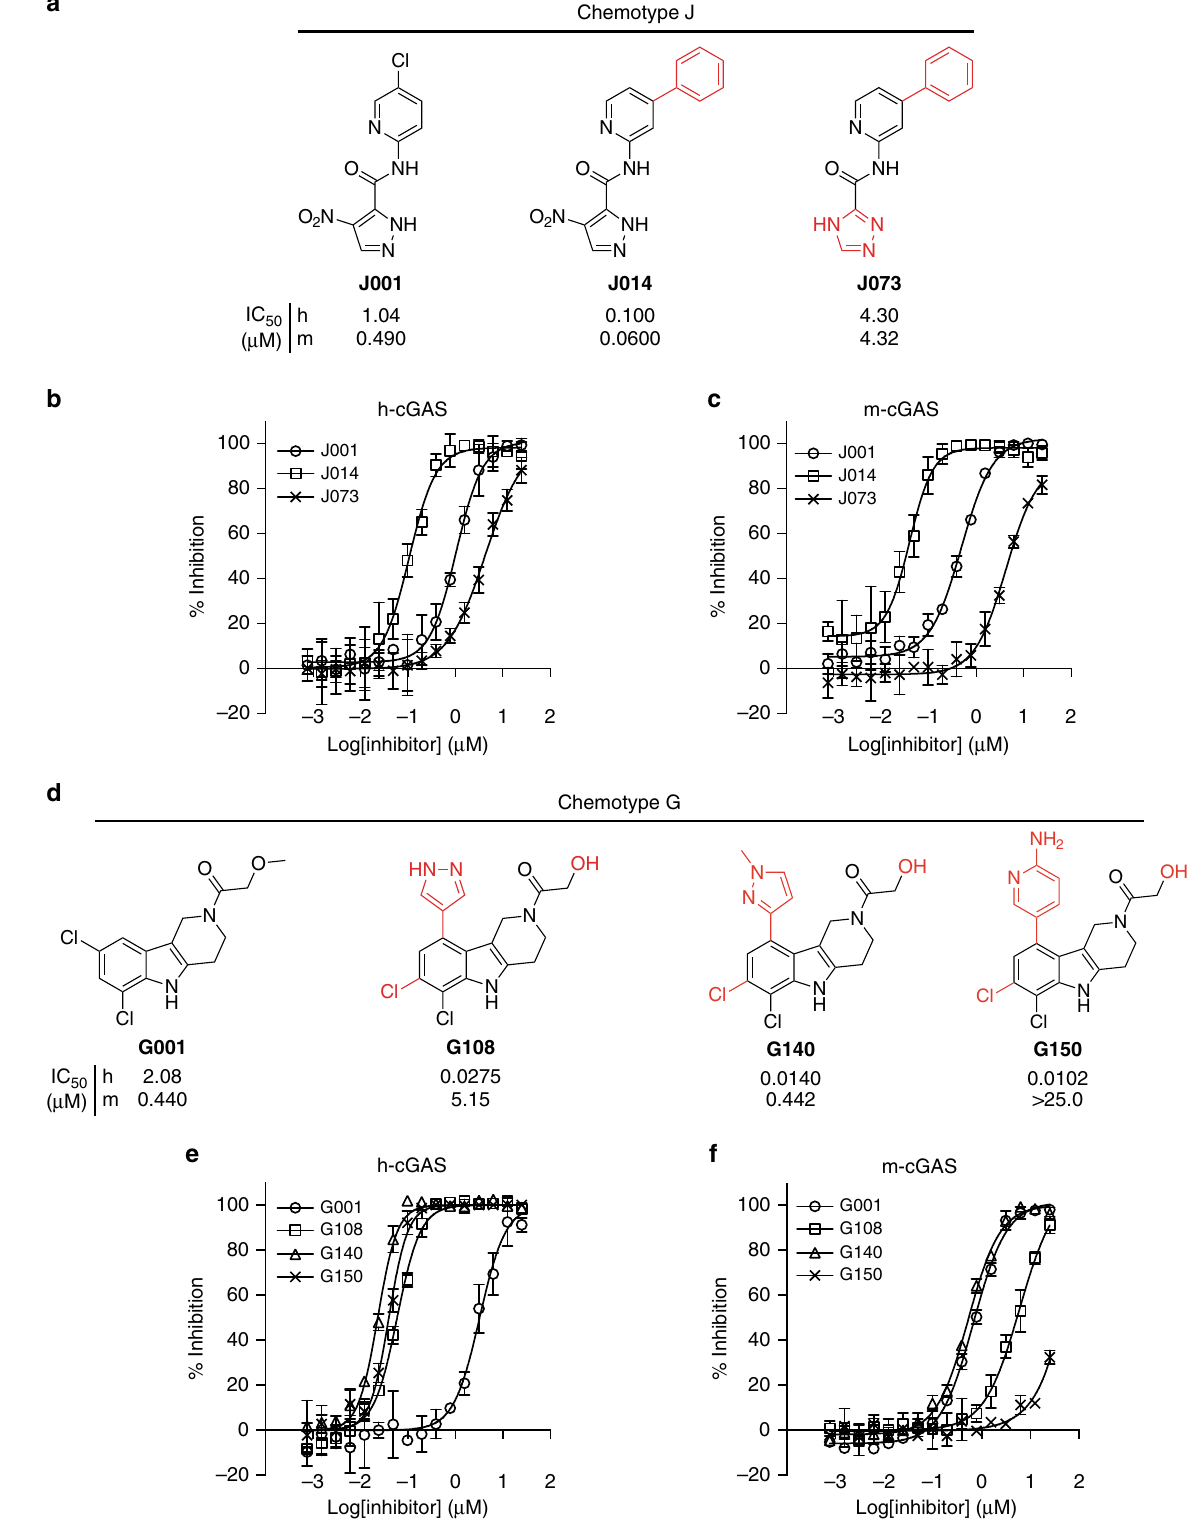
Fig. 3 cGAS inhibition by hit compounds J001 and G001 and their derivatives. a – c Chemical structures indicating IC 50 values against human (h) and mouse (m) cGAS ( a ) and in vitro concentration response curves ( b and c ) for compound J001 and its most active analogs. d – f Chemical structures showing IC 50 values against cGAS ( d ) and in vitro concentration response curves ( e and f ) for compound G001 and its most active analogs. IC 50 values were determined for the in-house synthesized compounds using RF-MS-based assay ( n = 3 for b , c , e , and f ; mean ± S.D. Data shown are representation of two independent